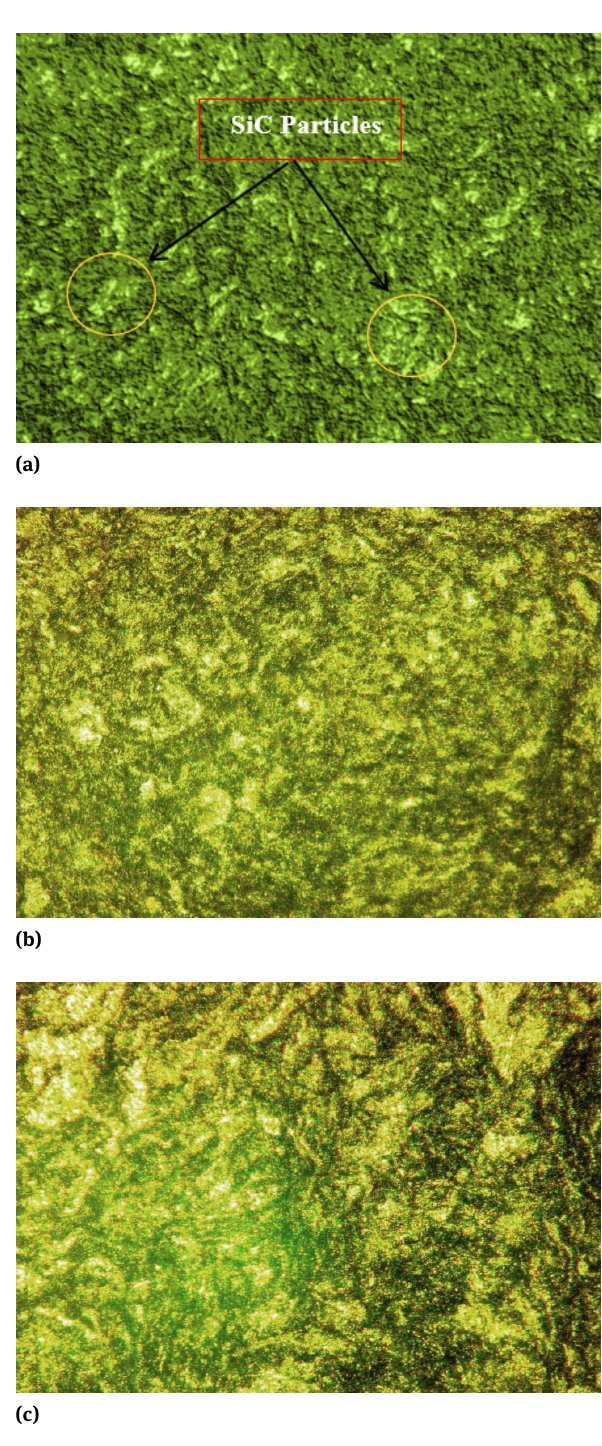
Figure 7: Microstructure of (a) Al alloy – 15% SiC), (b) Al alloy – 10% SiC) (c) Al alloy – 5% SiC), (600X